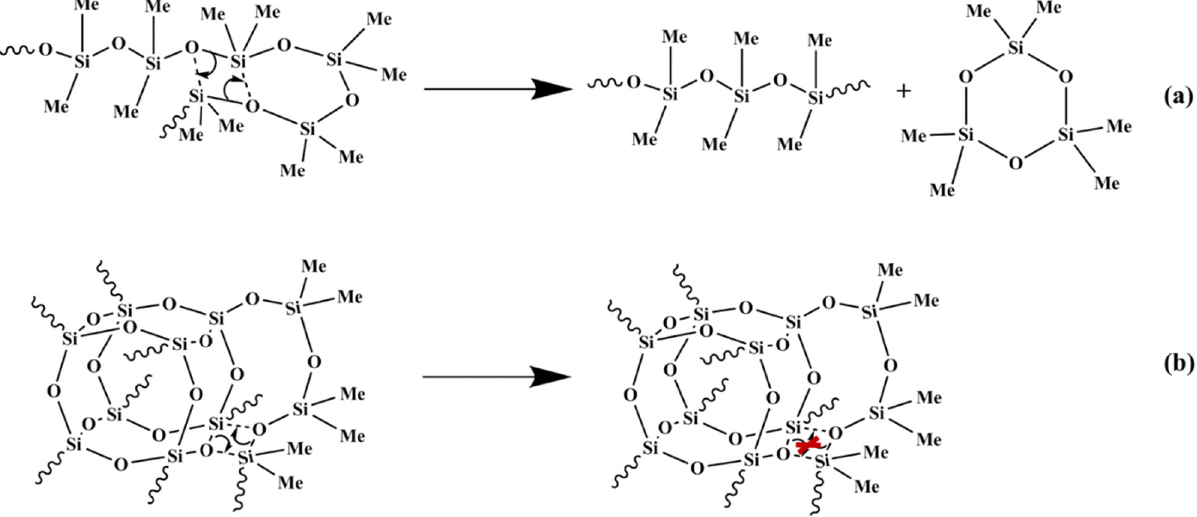
Figure 11: RTV silicone rubber degradation mechanism diagram: ( a ) without ODES and ( b ) with